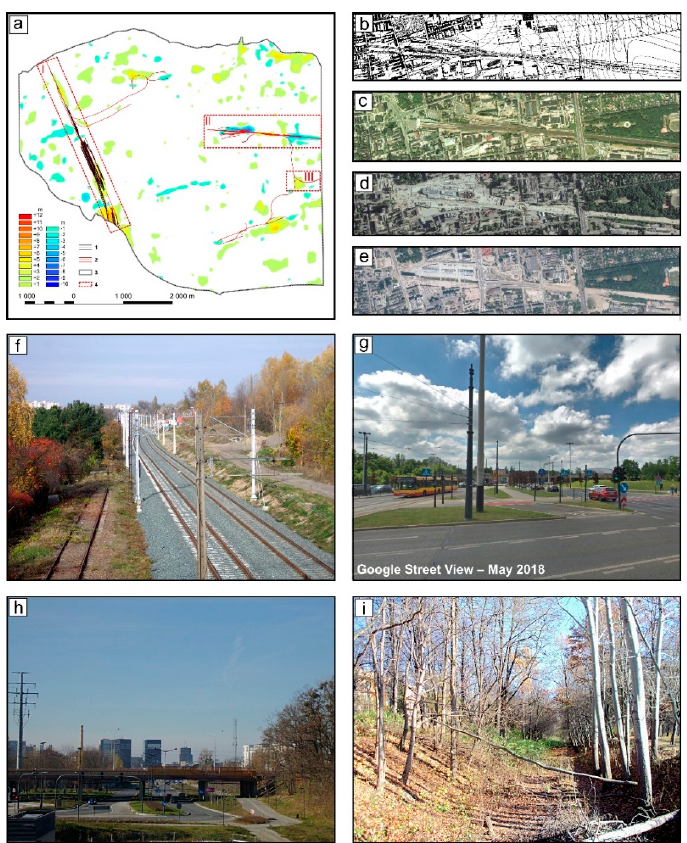
Figure 16. Changes in the relief of Ł ód ź associated with the railway and road transport network (photo A. Szmidt 2021). Na mapie brakuje trasy WZ ( a ) location map (1—non-existing tracks; 2— tracks existing at the beginning of the 20th century; 3—limits of Jasi ń ski’s Map development; 4— areas of analysis); ( b ) fragment of the area of the present Ł ód ź Fabryczna Railway Station on Jasi ń ski’s Map, ( c ) fragment of the area of the present Ł ód ź Fabryczna Railway Station on the 1996 aerial photo; ( d ) fragment of the area of the present Ł ód ź Fabryczna Railway Station on the 2015 aerial photo; ( e ) fragment of the area of the present Ł ód ź Fabryczna Railway Station in an aerial photo taken in 2018; ( f ) view on the beginning of the railway embankment in the vicinity of Ł ód ź Kaliska Railway Station; ( g ) view on the crossing near Ł ód ź Kaliska Railway Station; ( h ) location of the former railway trench and tracks in the vicinity of Ł ód ź Fabryczna Railway Station; ( i ) trench of the former railway line to K. Scheibler’s factories.